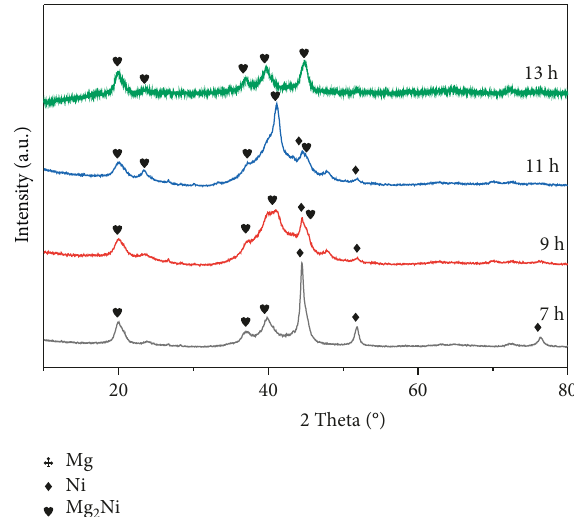
Figure 3: XRD patterns of HCX-2 ball milling for 7 h, 9 h, 11 h, and 13